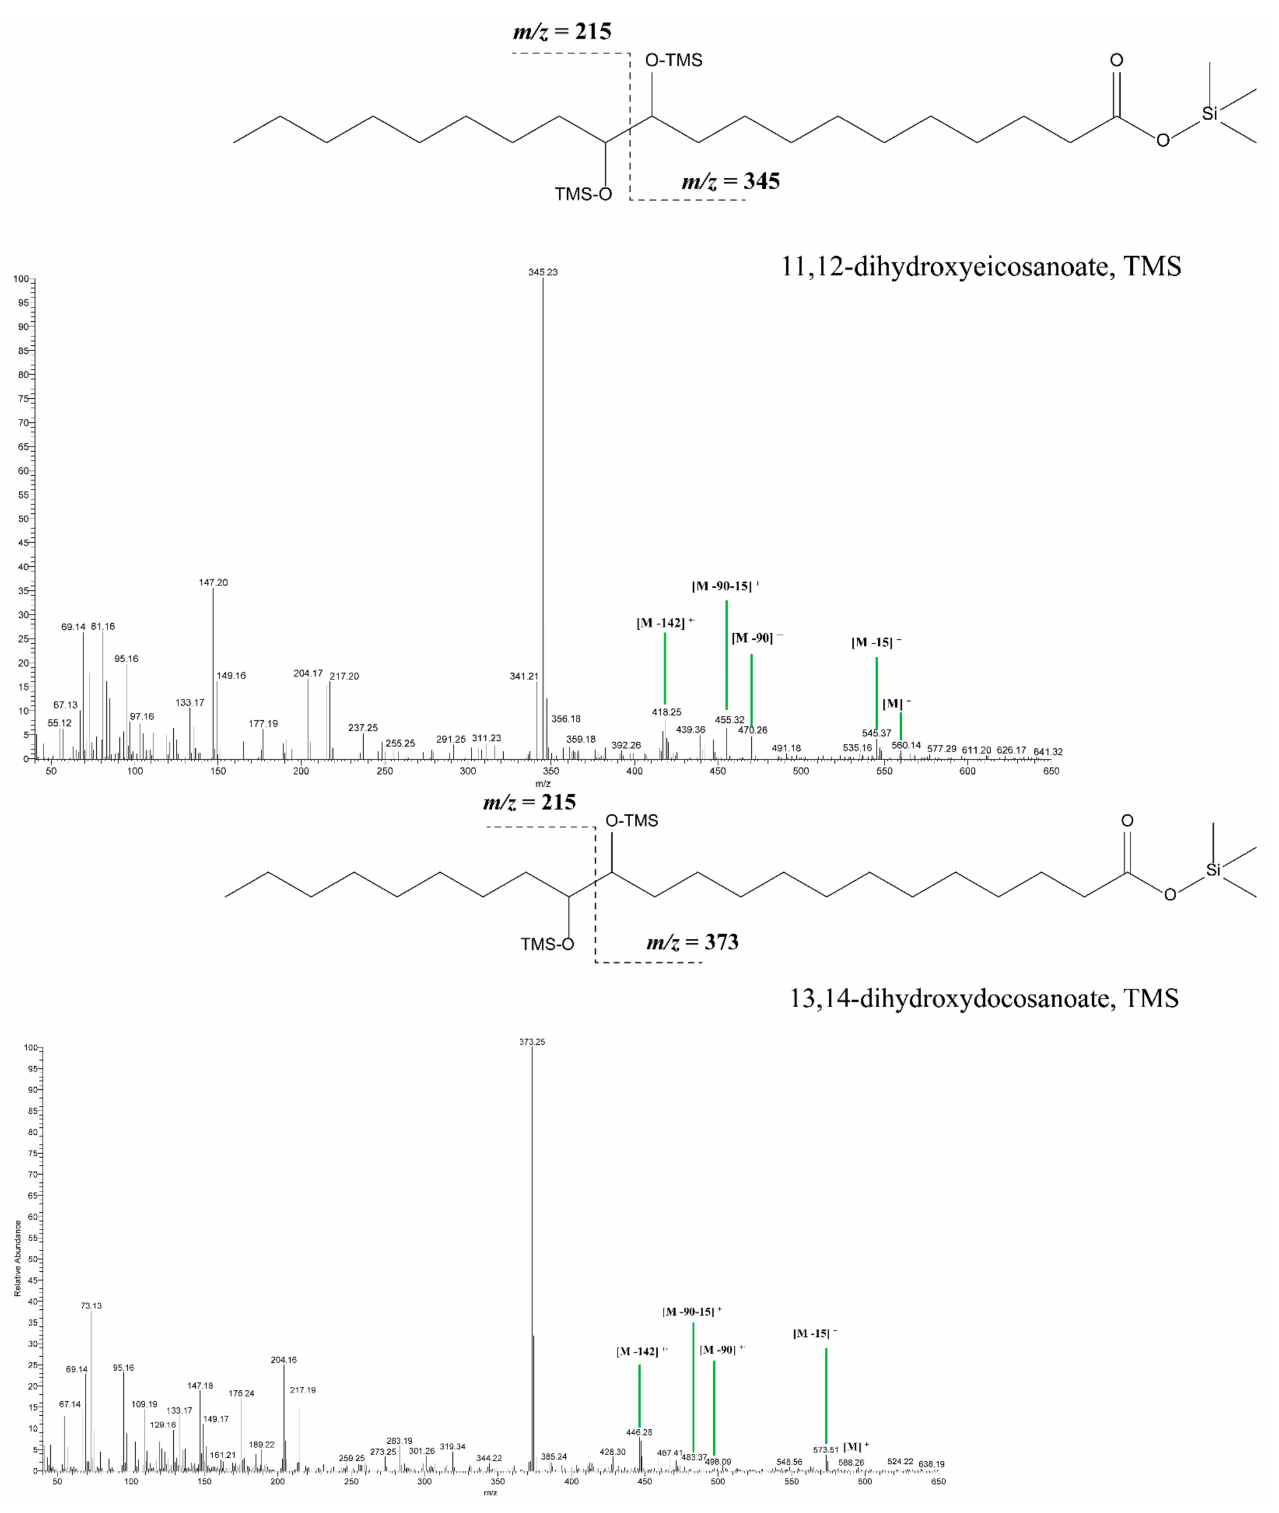
Figure 4. Mass spectra of threo/erythro isomers of 11,12-dihydroxyeicosanoate and 13,14- dihydroxydocosanoic